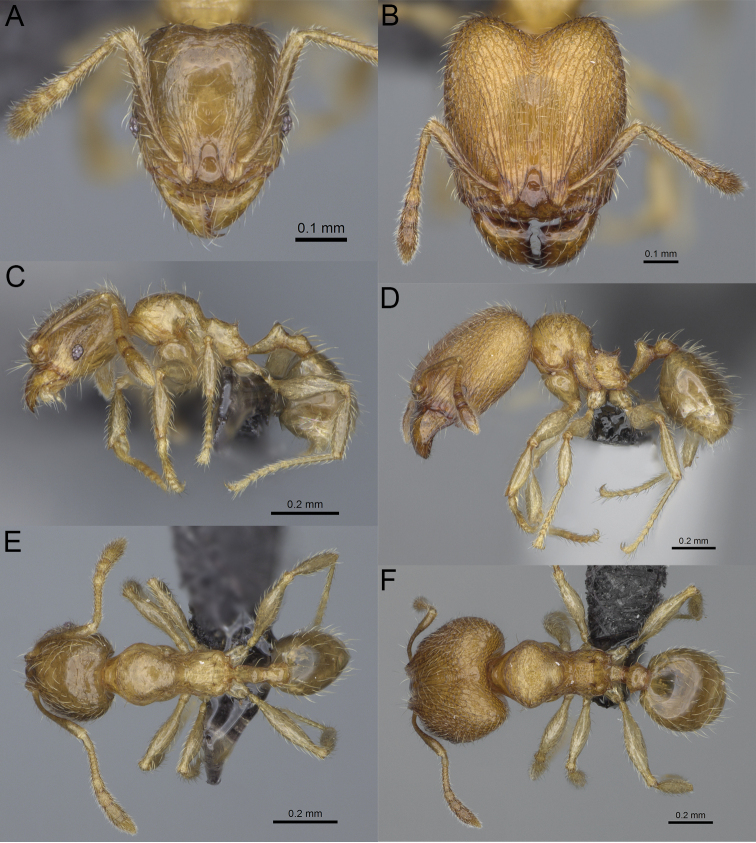
Pheidole
flavominuta sp. nov., full-face view (A), profile (C), and dorsal view (E) of paratype minor worker (CASENT0162186) and full-face view (B), profile (D), and dorsal view (F) of holotype major worker (CASENT0923272).